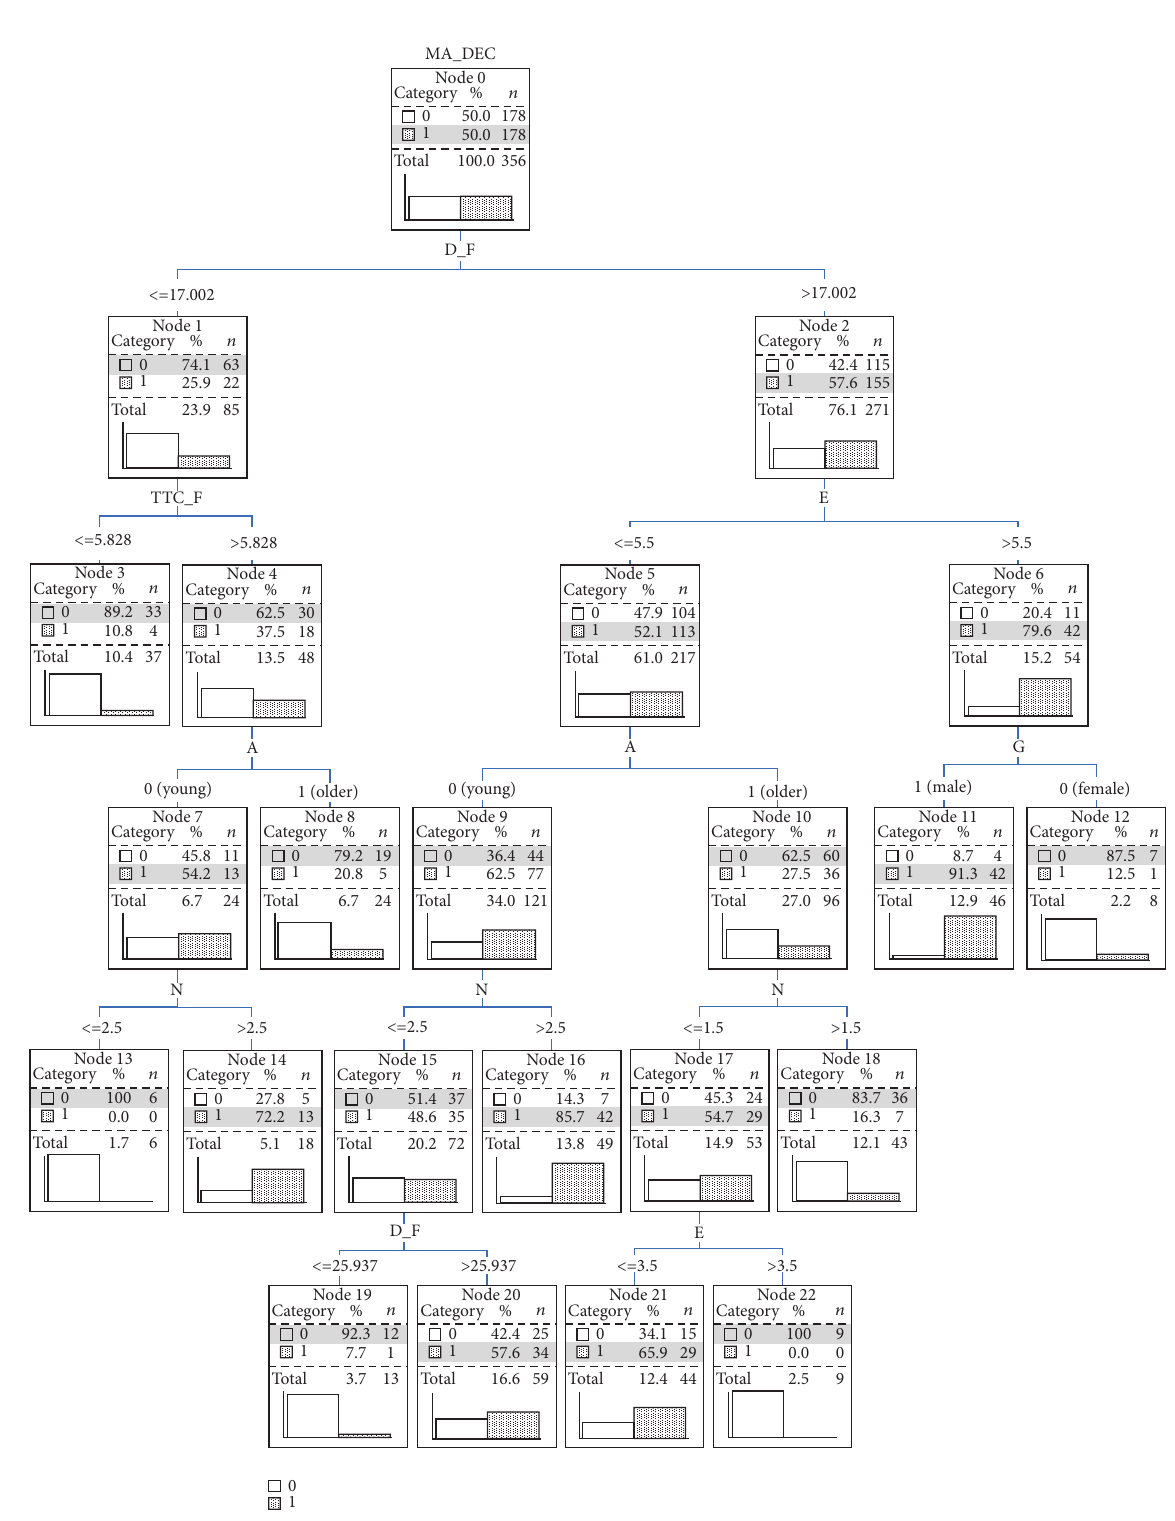
Figure 6: DT diagram for the maneuver decision model for cut-in